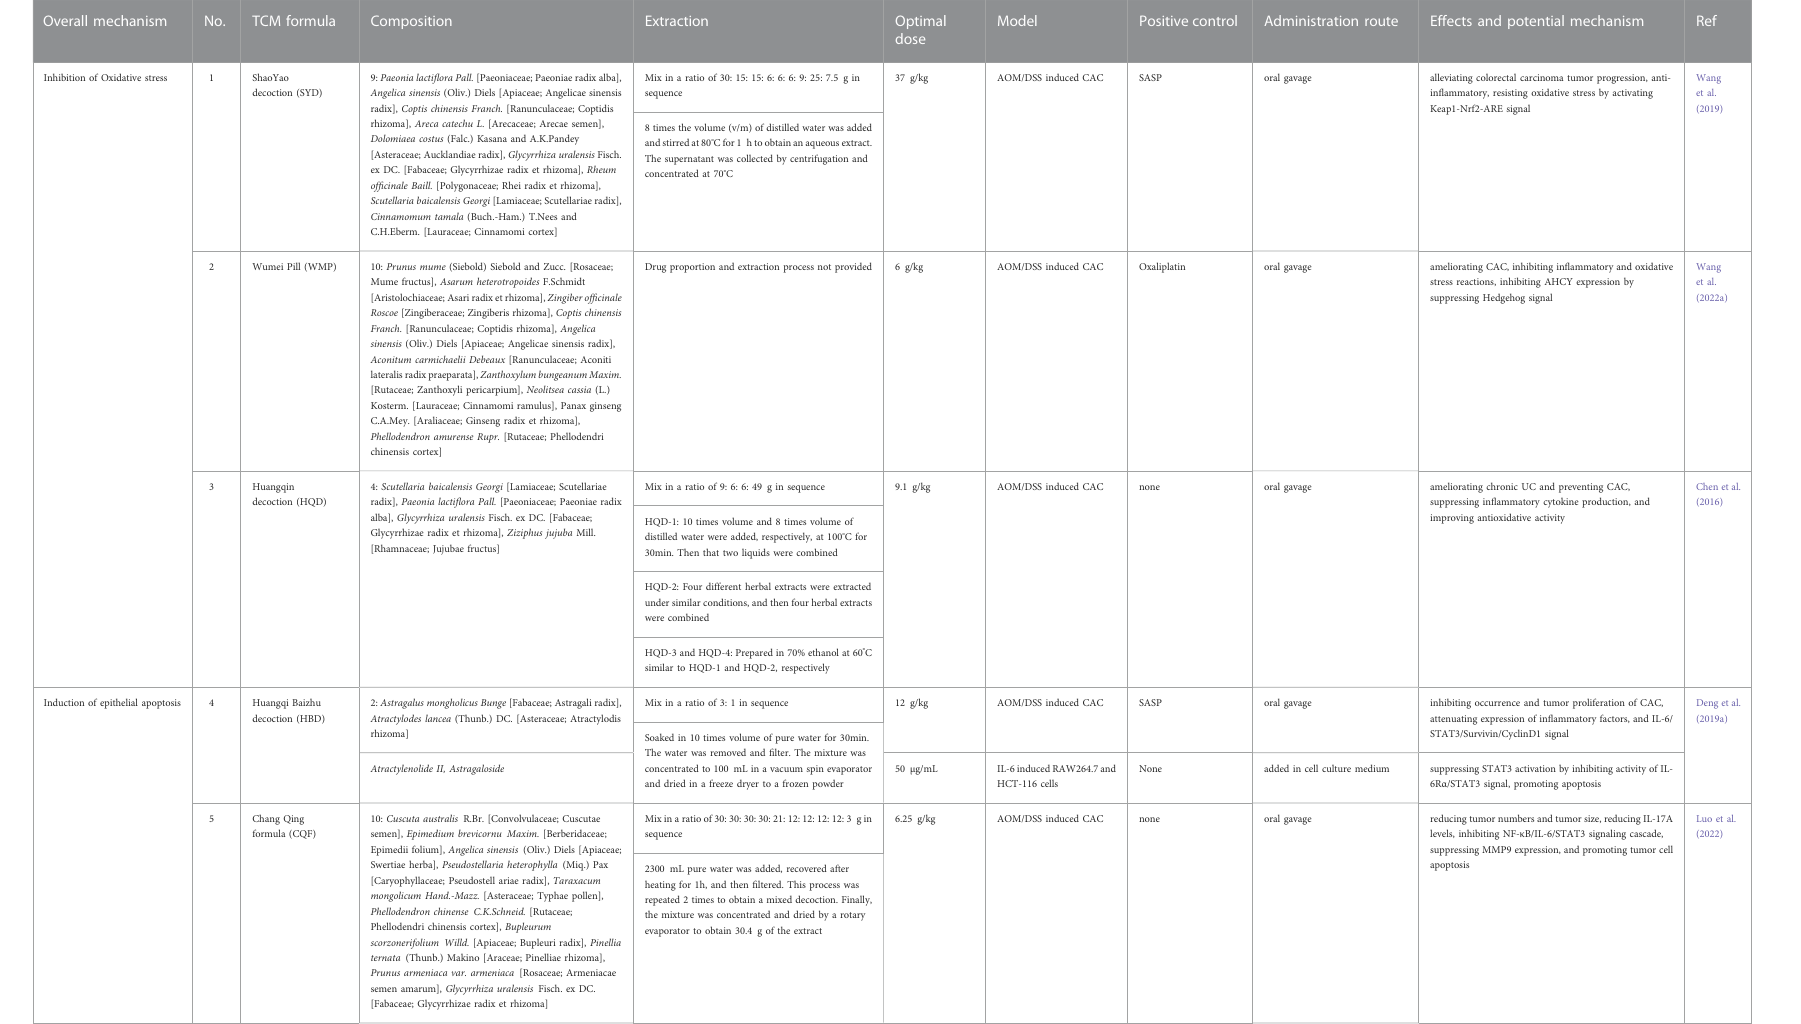
TABLE 1 Lists of TCM formulas with potential anti-CAC